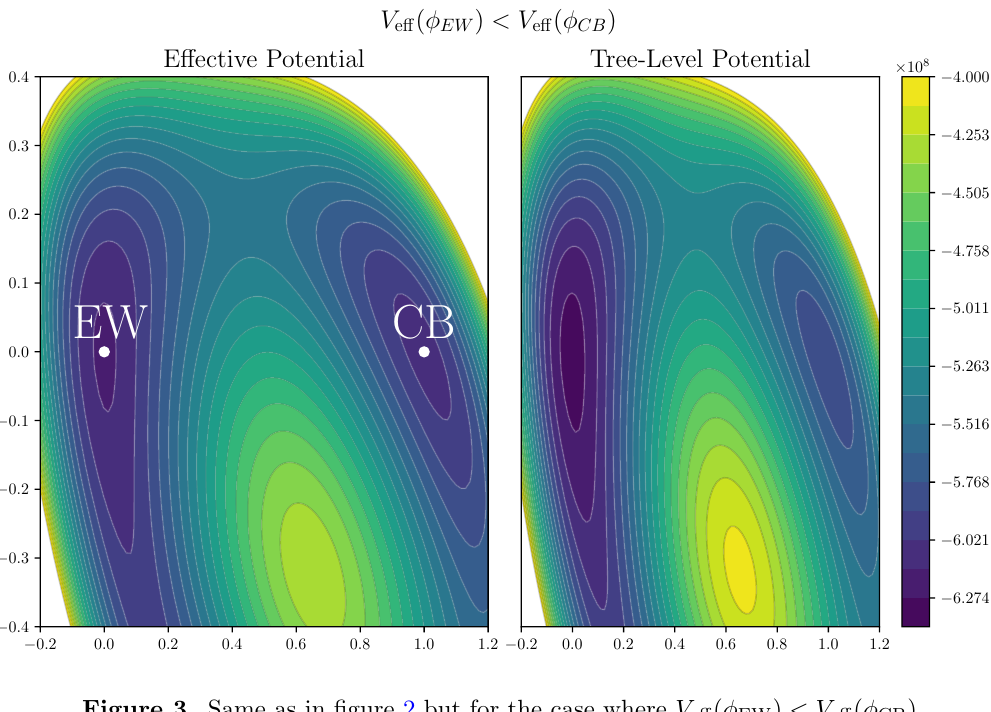
e(cid:11) ( (cid:30) EW ) < V e(cid:11) ( (cid:30) CB ).